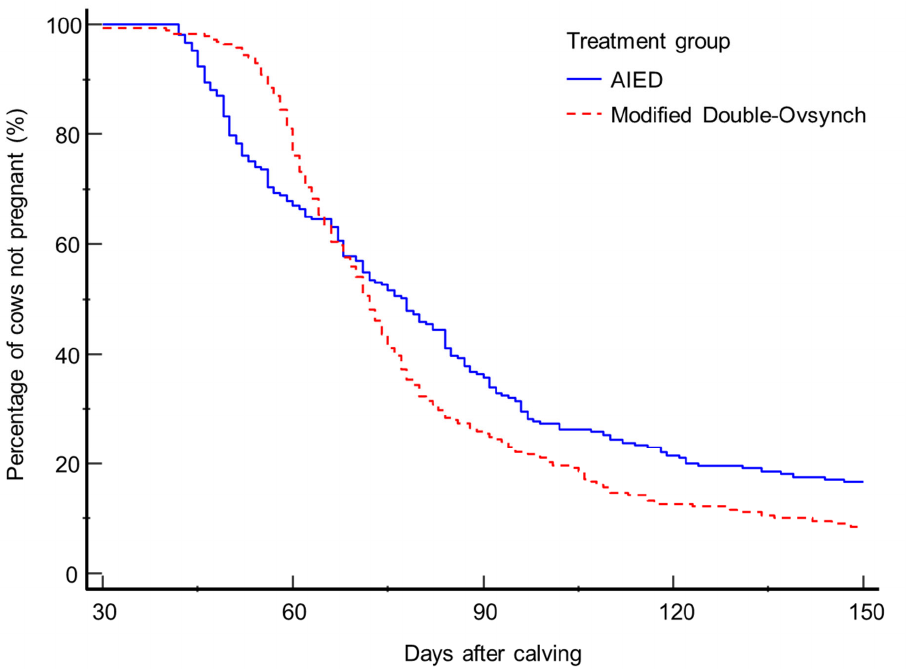
Figure 3. Survival curves generated using MedCalc software for the interval between calving and pregnancy for the modified Double-Ovsynch (n = 203) and AIED (n = 209) groups. The probability of pregnancy by 150 days postpartum was higher in the modified Double-Ovsynch group (hazard ratio: 1.28, p<0.05) than in the AIED group. The median and mean number of days between calving and pregnancy tended to be shorter (p<0.1) in the modified Double-Ovsynch group (72 and 81.9±2.1 days) than in the AIED group (78 and 85.9±2.5 days). AIED, artificial insemination following estrus detection.